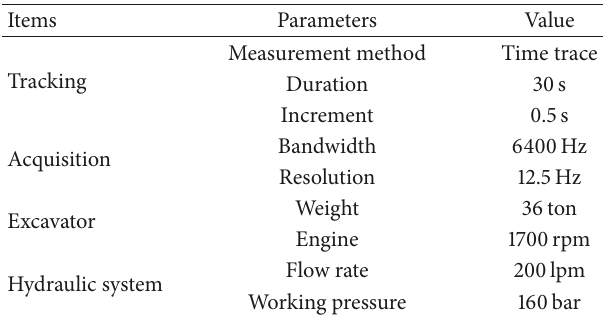
Table 1: Parameters for vibration experiments and operating condi- tions for the excavator.